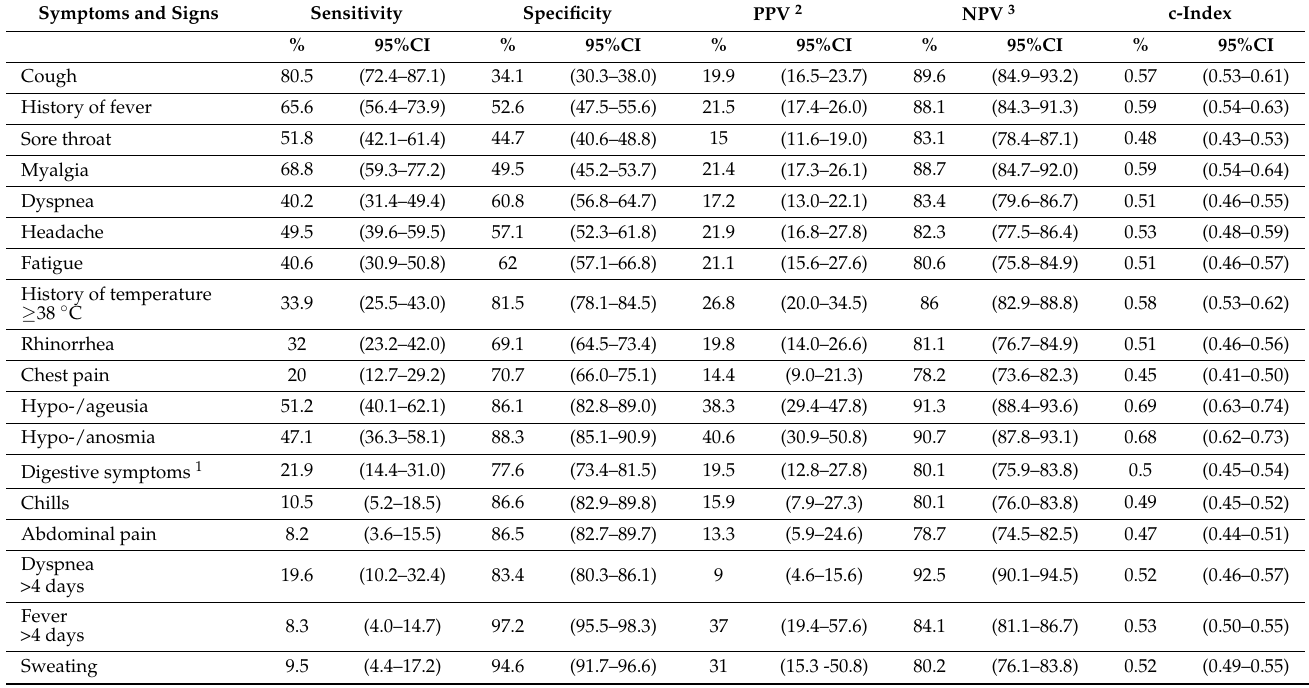
Table 2. Diagnostic performance of individual symptoms to predict positive RT-PCR test